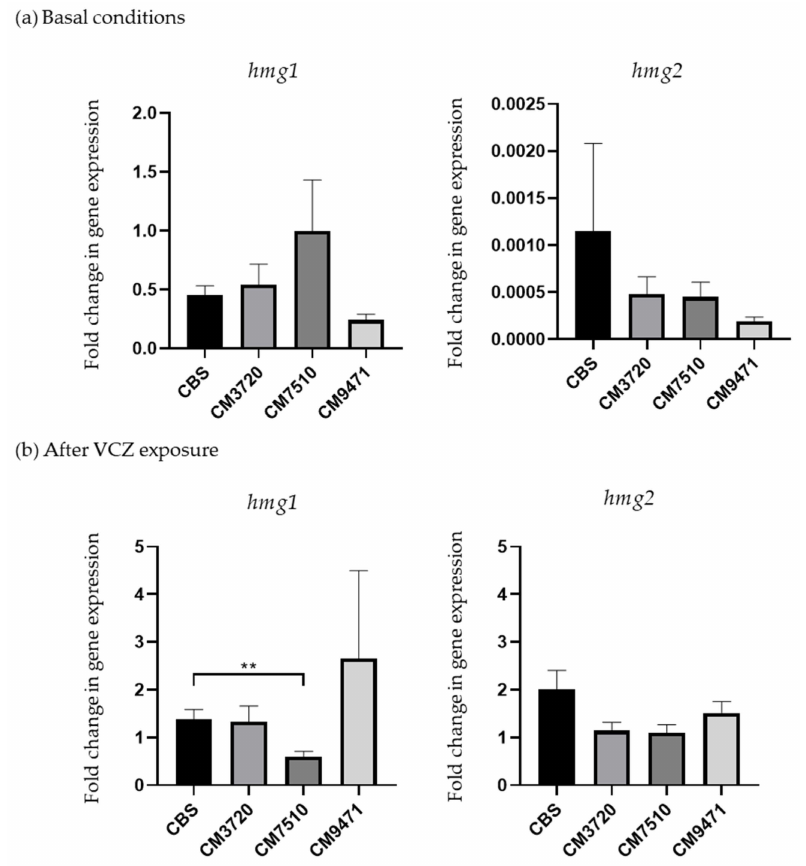
Figure 1. Expression analysis of hmg1 and hmg2 genes in a wild-type A. fumigatus strain (CBS) and three hmg1/2 -mutated strains: CM3720 (G307D, I312S), CM7510 (P309L) and CM9471 (D242Y). ( a ) Expression after overnight growth of the strains in basal conditions. ( b ) Relative expression of hmg1 and hmg2 genes in strains after one hour of VCZ exposure relative to basal conditions. ** p <